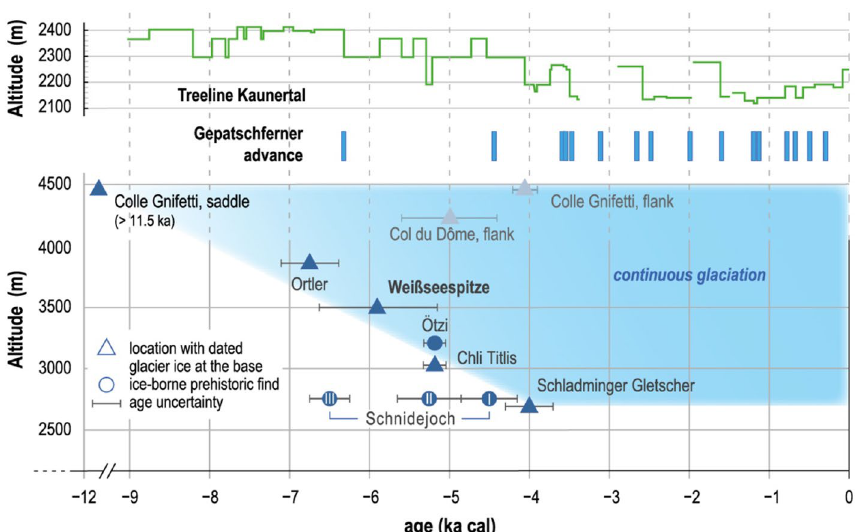
Figure 4. Compilation of dated past neoglaciation events at high-elevation locations in the Alps. Note the general correspondence between glacier maximum age and its altitude. The blue shaded area indicates the period of continuous ice cover. Also shown are the tree line reconstruction from Kaunertal 26 and the reconstructed advances of Gepatschferner greater than its 1960 extent 21 . References: Colle Gnifetti saddle 19,31 , flank 20 ; Col du Dome 32 ; Ortler 9 ; Iceman “Ötzi” 14,16 ; Chli Titlis and Schladminger Glacier 12 ; Schnidejoch 15 . Figure made with licensed software Adobe Illustrator CS6 (https ://www.adobe